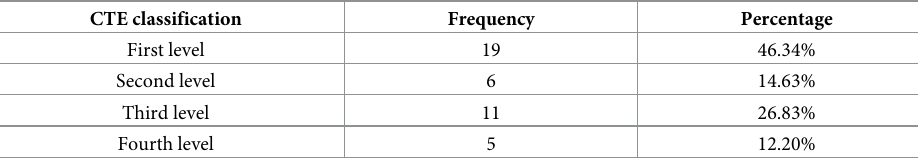
Table 3. Grade distribution of comprehensive technical efficiency.